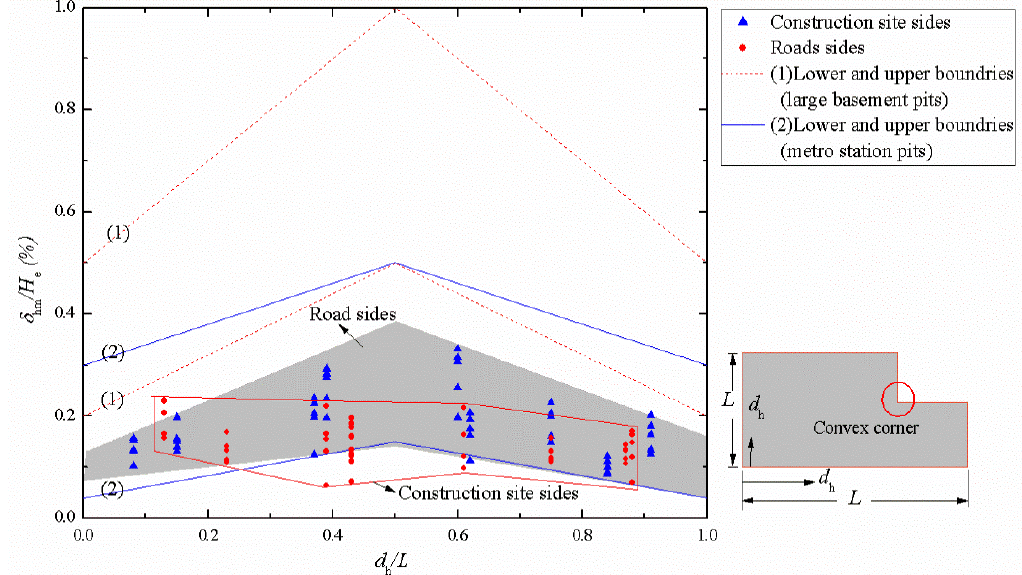
Figure 9. Distribution of normalized maximum lateral wall displacements along the sides.